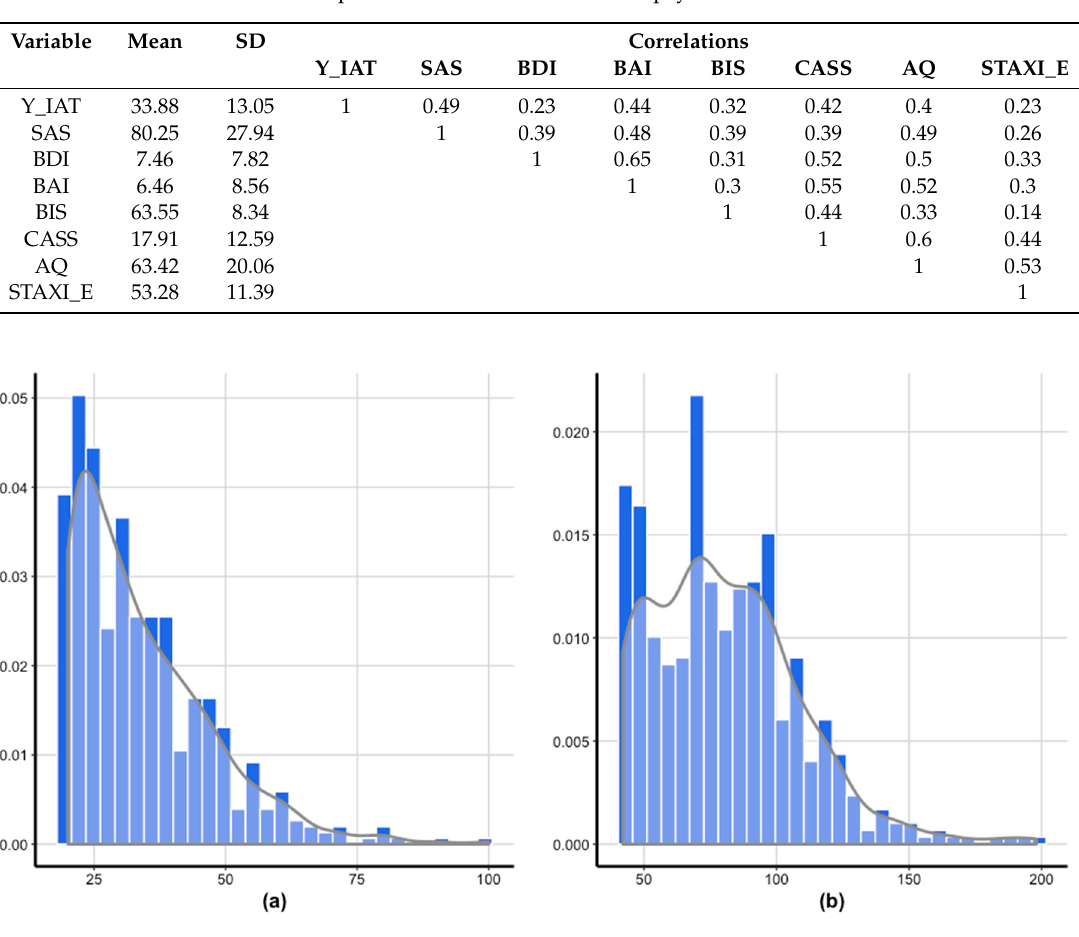
Table 1. Descriptive statistics of addiction and psychosocial measures.